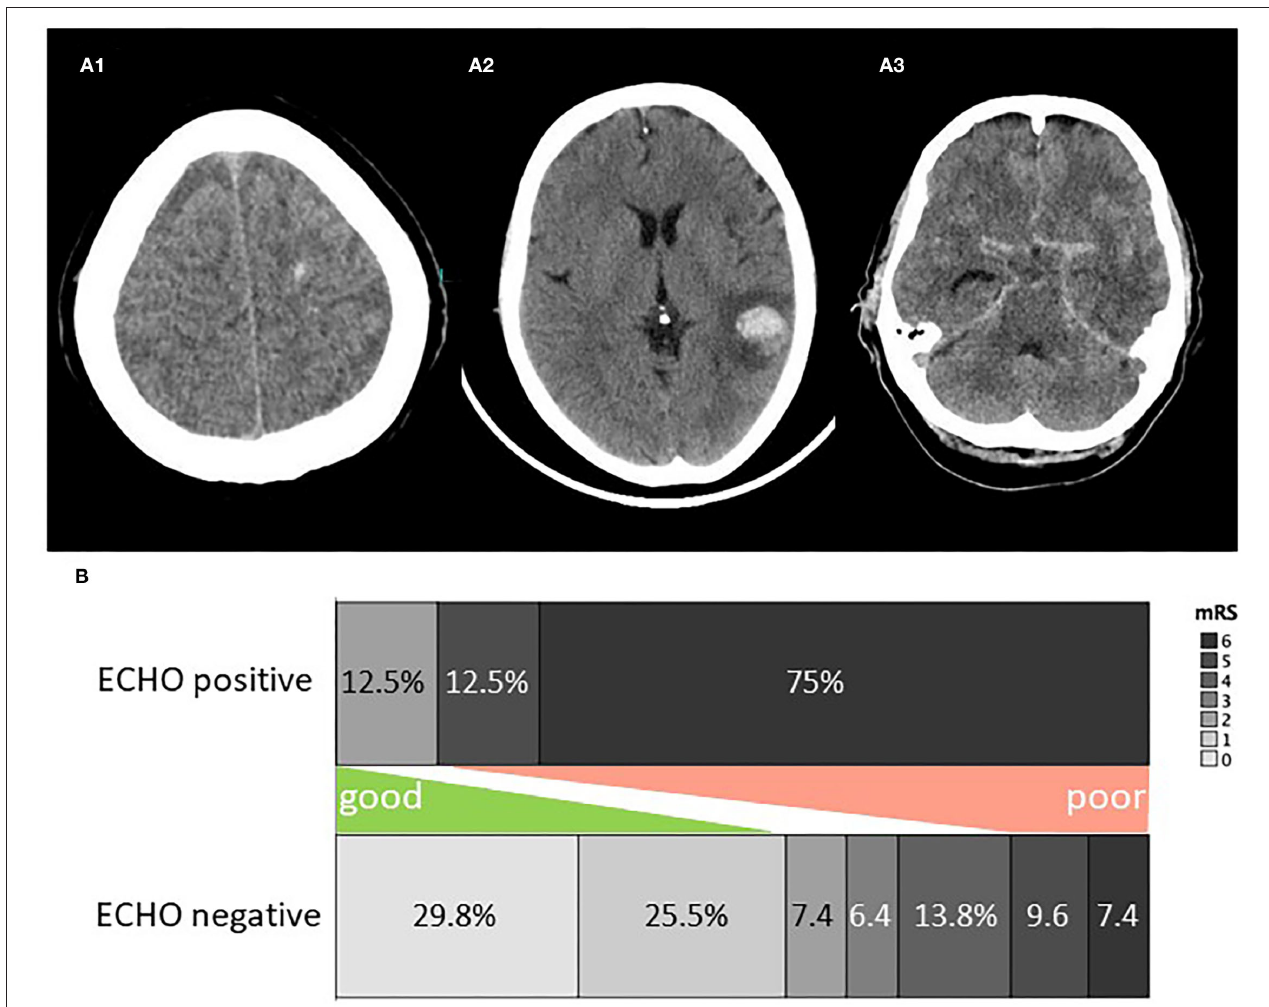
FIGURE 1 | (A) Examples of ECHO on cerebral imaging. (A1) Microhemorrhage, (A2) lobar hemorrhage, (A3) subarachnoid hemorrhage. (B) Clinical outcome for ECHO positive and negative patients. ECHO, early cerebral hemorrhage; mRS, modified rankin scale